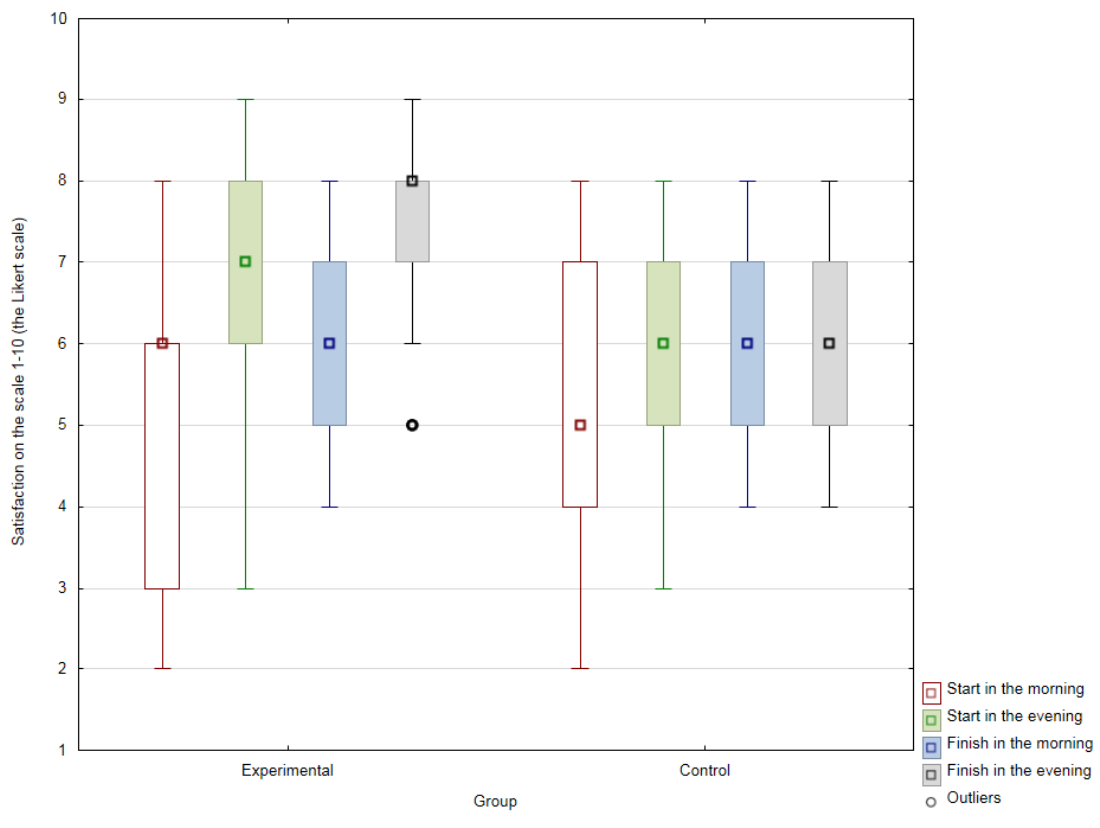
Figure 1. Comprehensive comparison of values reported by patients for subjectively perceived general mood on the scale 1 – 10 (the Likert scale). Figure terminology is described